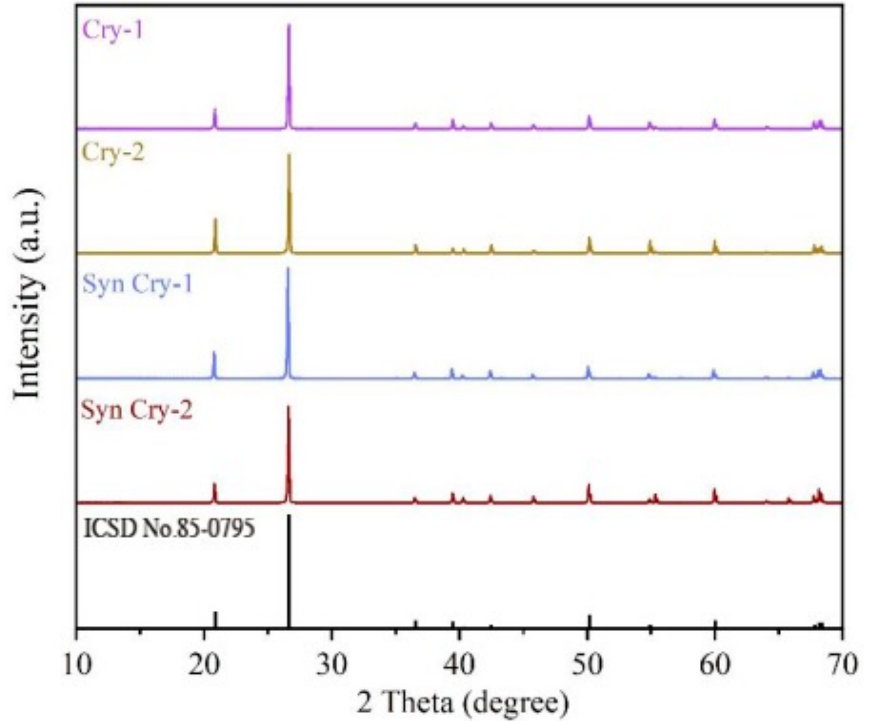
Figure 2. The XRD patterns of Cry-1, Cry-2, Syn Cry-1 and Syn Cry-2 samples. Table 1. The cell parameters of Cry-1, Cry-2, Syn Cry-1 and Syn Cry-2 samples. Samples